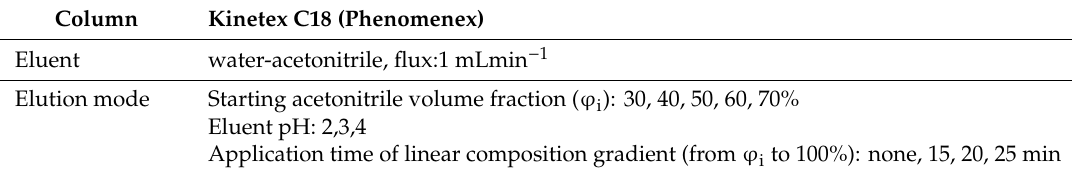
Table 1. Chromatographic conditions utilized to collect the retention